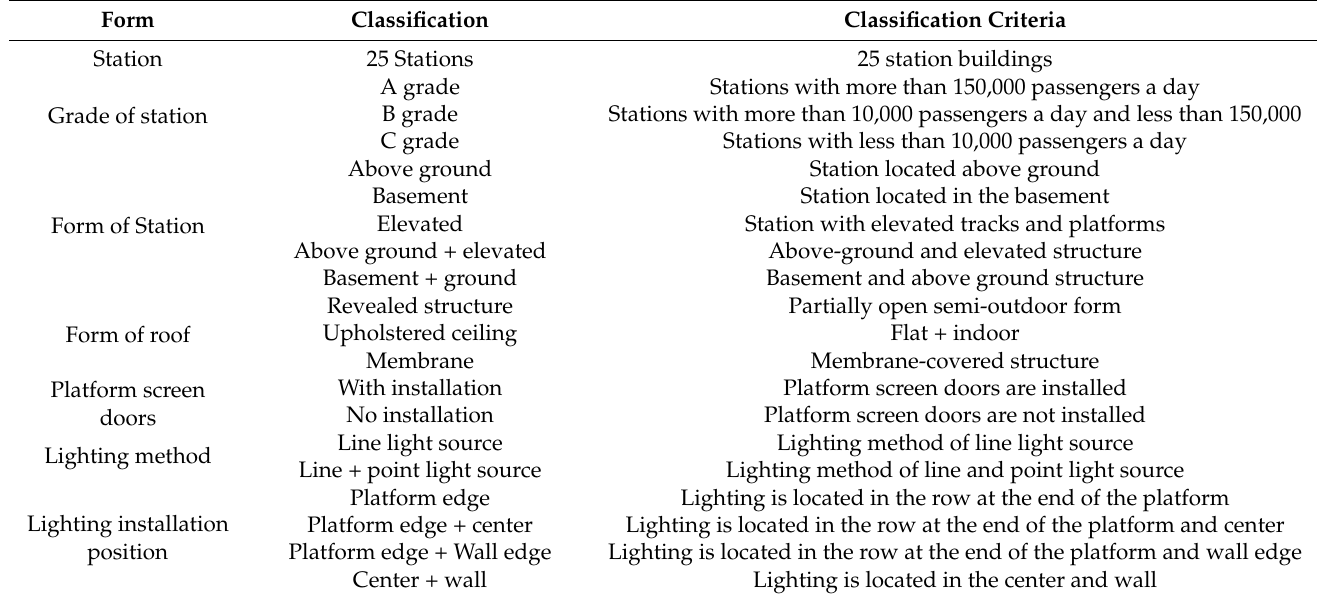
Table 1. Form classification criteria table of the platform.